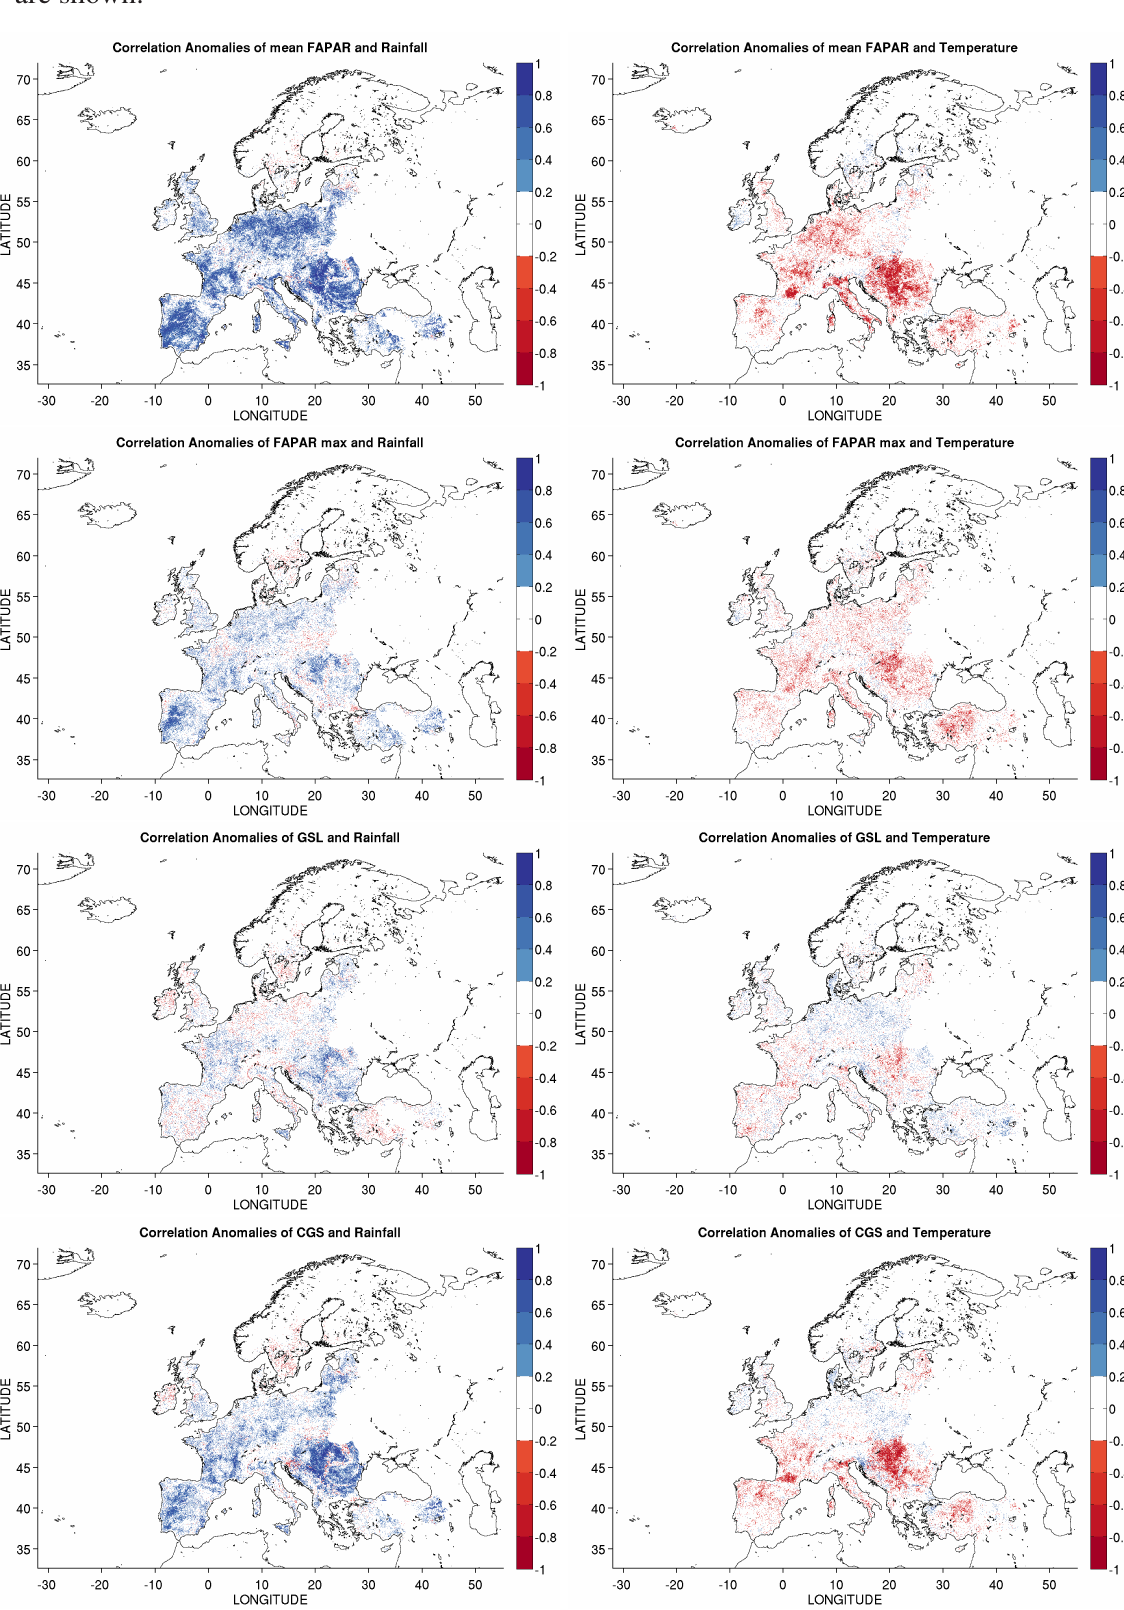
Figure 6. Pearson’s correlation coefficient between the four phenology metrics and anomalies of rainfall ( left ) and temperature ( right ). Only significant ( p = 0.05) correlations are